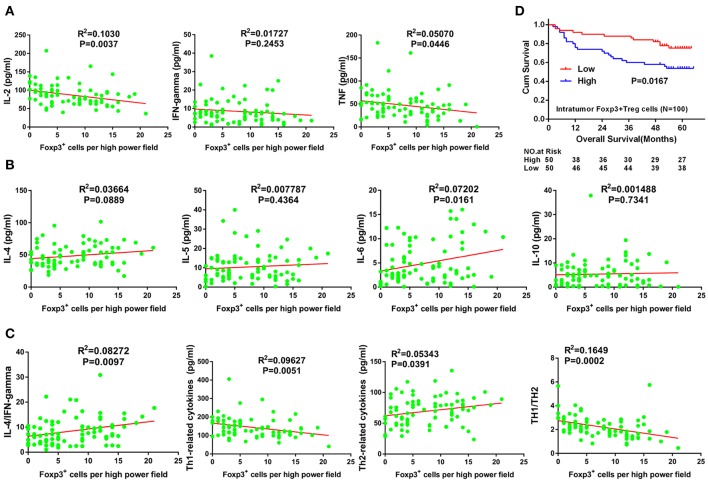
Correlation between Tregs number and Th1/Th2 cytokine expression, and its prognostic significance in GC. (A) Th1 (pro-inflammatory) cytokines including IL-2, TNF-α, and IFN-γ. (B) Th2 (anti-inflammatory) cytokines including IL-4, IL-5, IL-6, and IL-10. (C) Total Th1 cytokines, total Th2 cytokines, IL-4/IFN-γ ratio and total Th1 cytokines/total Th2 cytokines ratio. Cum, cumulative; GC, gastric cancer; IFN-γ, interferon gamma; IL, interleukin; TNF-α, tumor necrosis factor alpha.